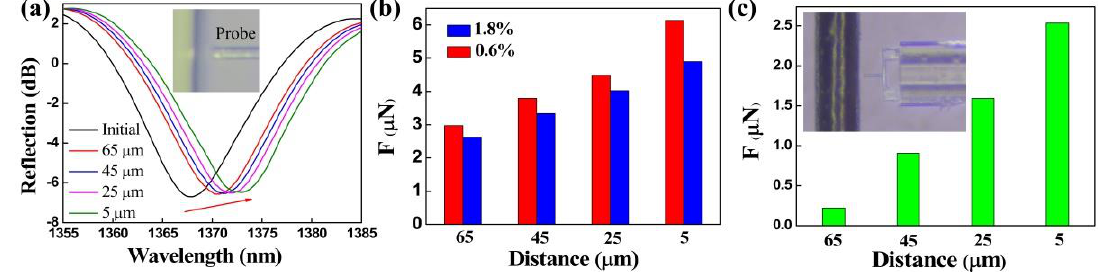
Figure 5. ( a ) Probe of the FTMS was encapsulated by micro-protrusions of the hydrogel under the effect of the adhesion force. ( b ) Simulation results for adhesion of the FTMS to agarose hydrogels. ( c ) Evolution of the reflection spectrum under the action of the adhesion.